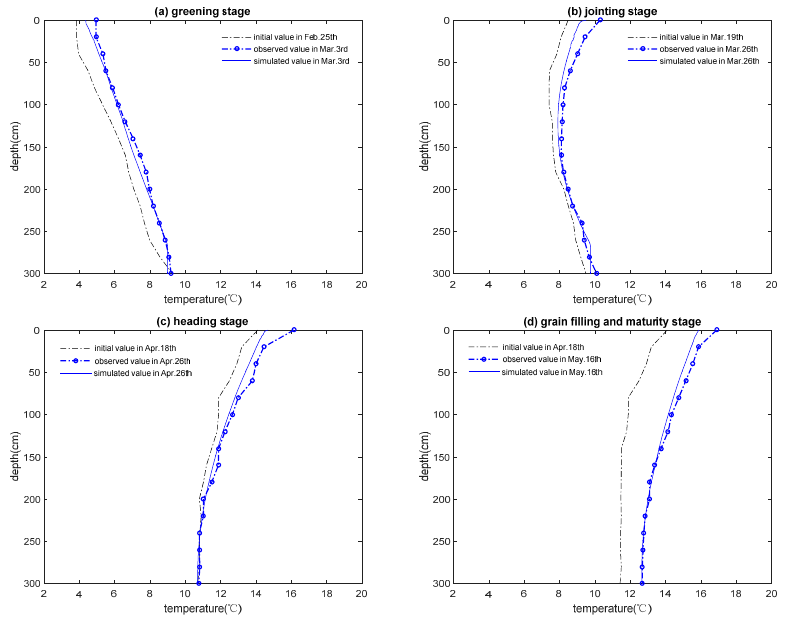
Figure 5. Comparison between simulated and observed values for soil temperature in different stages of wheat growth.